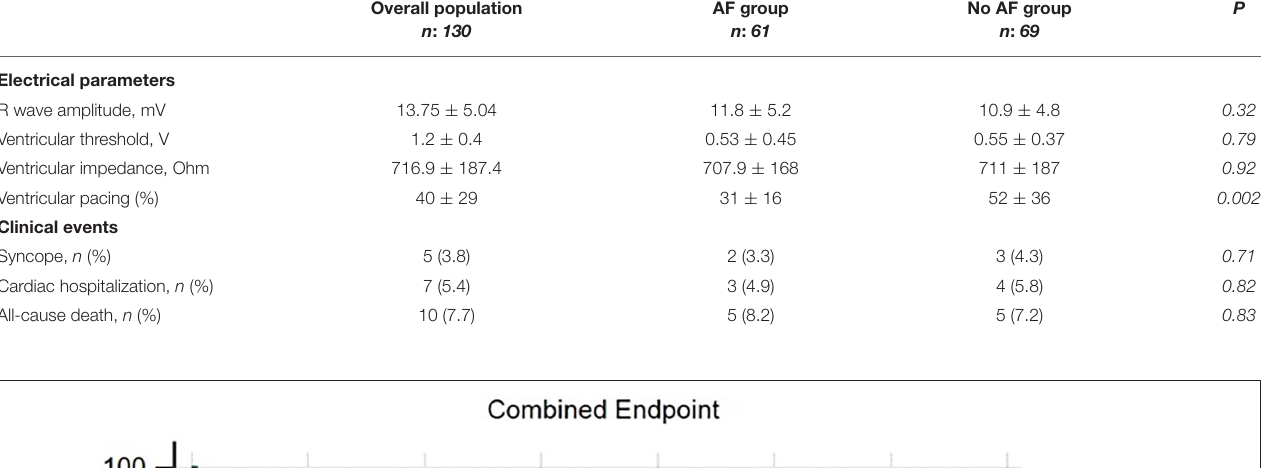
TABLE 4 | Electrical parameters and clinical events at follow-up.